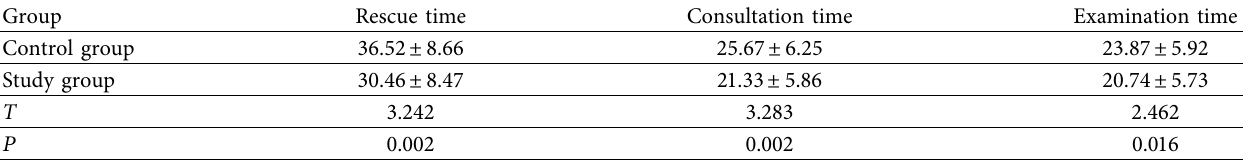
Table 1: Comparison of treatment time data between the control group and the study group ( n � 42, x ± s , min). Group